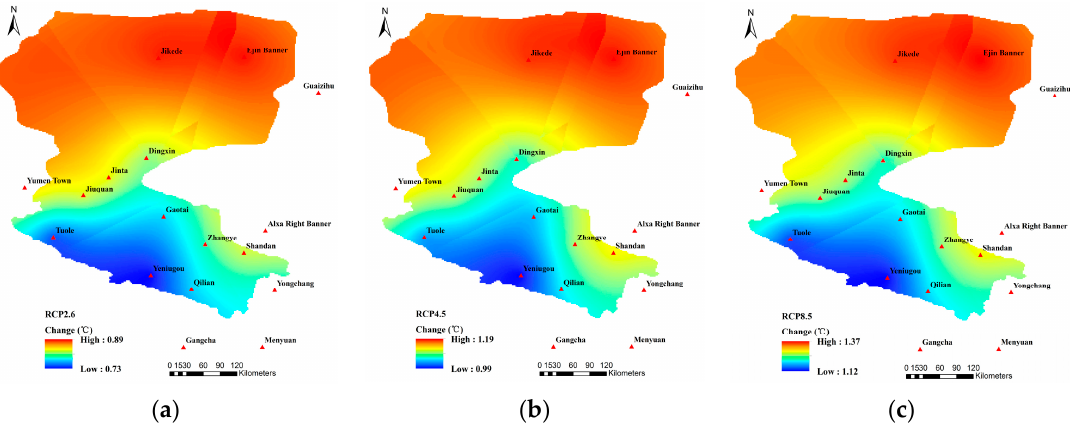
Figure 4. Spatial variation patterns of the T mean under ( a ) RCP2.6; ( b ) RCP4.5; and ( c ) RCP8.5.